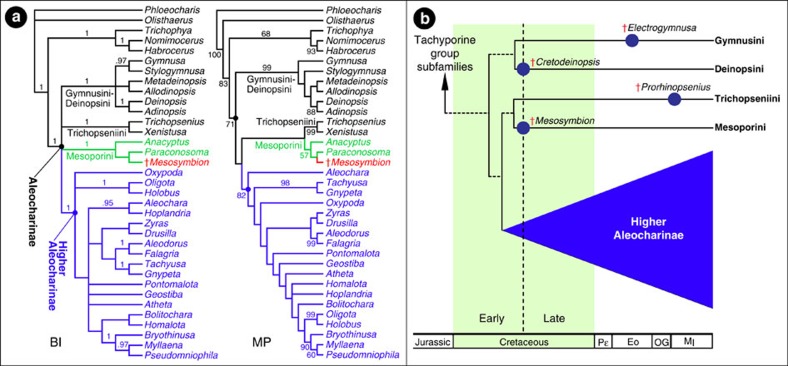
Phylogenetic position of Mesosymbion and implications for the timeframe of aleocharine evolution.(a) Consensus trees from Bayesian inference (BI) and maximum parsimony (MP) analysis of Mesosymbion and representative aleocharines and tachyporine group taxa. Posterior probabilities above 0.9 are shown on branches in the BI tree; bootstrap percentages >50 from 10,000 replicates are shown on the MP tree (strict consensus of two trees: length 542 steps, CI=0.45, RI=0.65). (b) Proposed scenario of early cladogenetic events in Aleocharinae, employing the topology from Ashe34 and our MP analysis in a, scaled by the earliest-known fossils of Deinopsini and Mesoporini (blue circles indicate oldest fossils known for each basal lineage outside of the higher Aleocharinae).